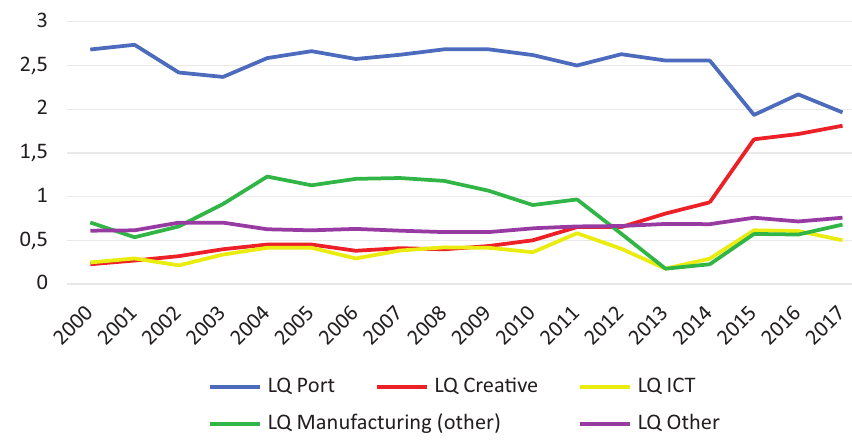
Figure 2. Location quotient results for M4H by sector classification. Source: LISA (2017; data from 2000–2017).